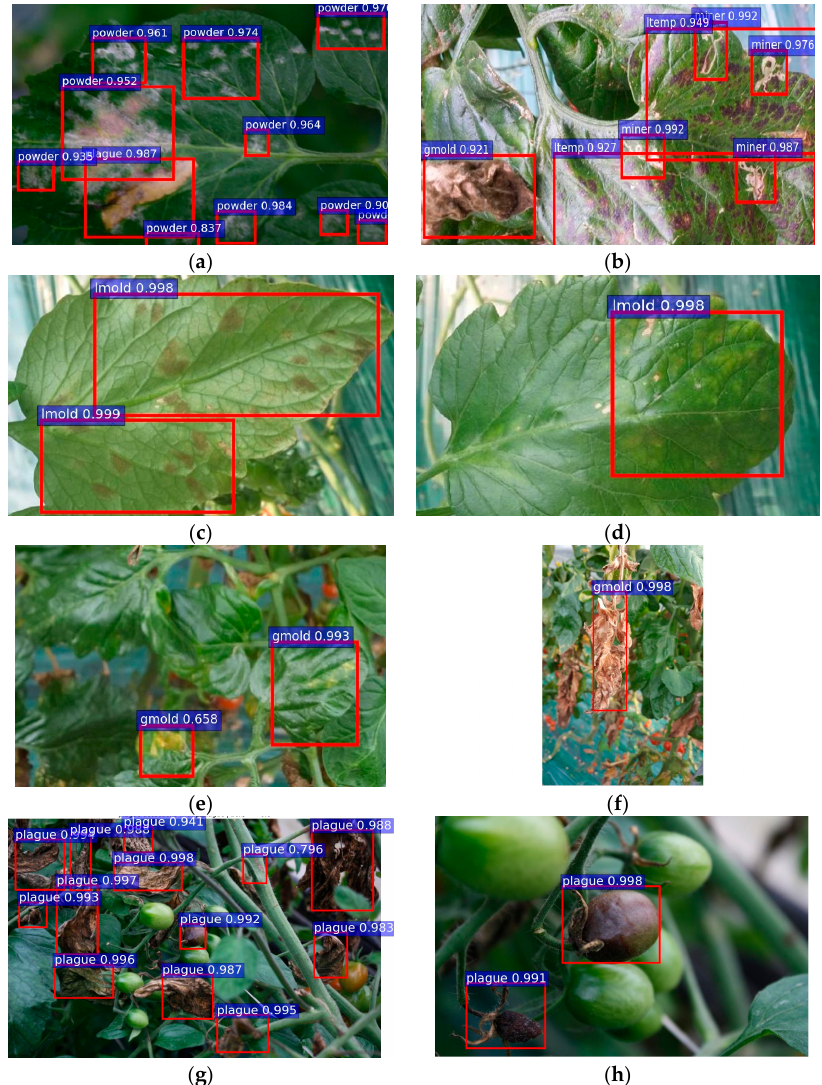
Figure 8. Detection results of inter- and intra-class variation of diseases and pests in the images. ( a ) Two classes affecting the same sample (powdery mildew and pest); ( b ) Three classes in the same sample (Gray mold, low temperature, and miners); ( c ) Leaf mold affecting the back side of the leaf; ( d ) Leaf mold affecting the front side of the leaf; ( e ) Gray mold in the early stage; ( f ) Gray mold in the last stage; ( g ) Plague can be also detected on other parts of the plant, such as fruits or stem; ( h ) Plague affecting the tomato production.